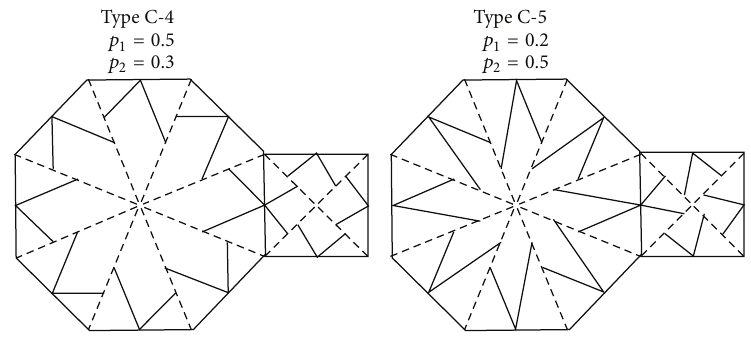
Figure 27: Examples of additional variations: Type C.